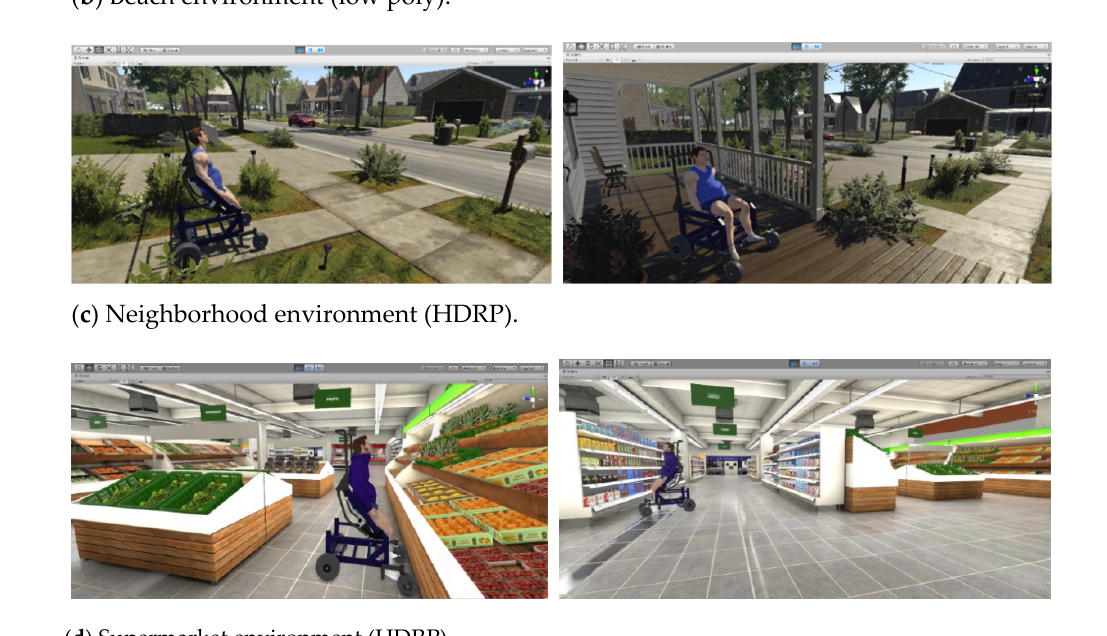
Figure 16. Screenshots of the developed virtual environments for the execution of rehabilitation tasks and robotic assistance, all related to activities of daily living.